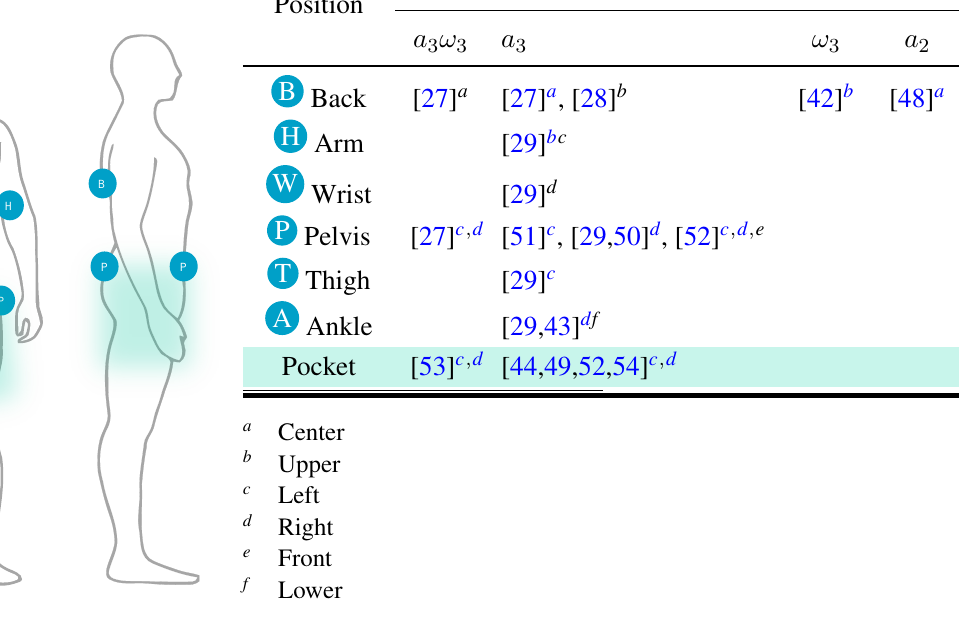
Figure 3. Sensor